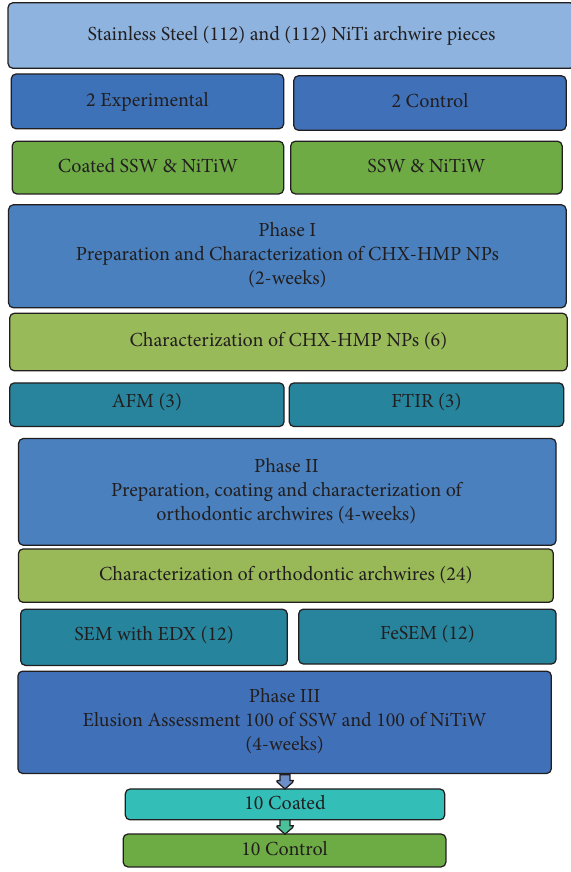
Figure 1: Diagram showing the study design, sample size, and